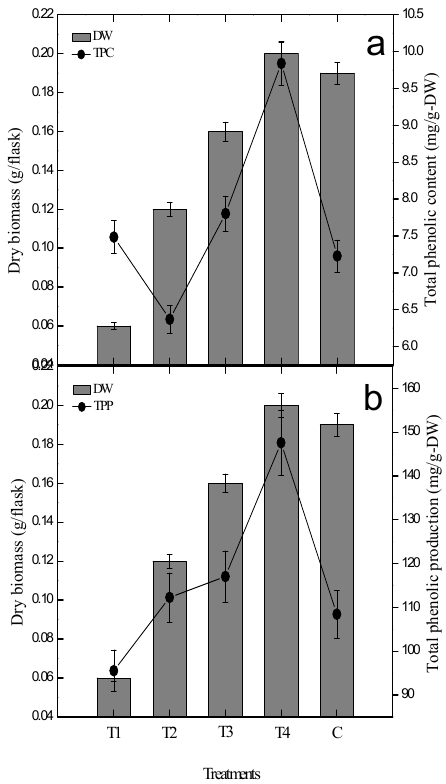
Figure 2. Biomass and PGRs (plant growth regulators) show dependent linear and positive correlation with phenolics biosynthesis ( a ) and phenolics production ( b ) in S. rebaudiana adventitious root cultures in vitro. The triplicate data in the mean along with standard errors (SE) are significantly different at p < 0.05.